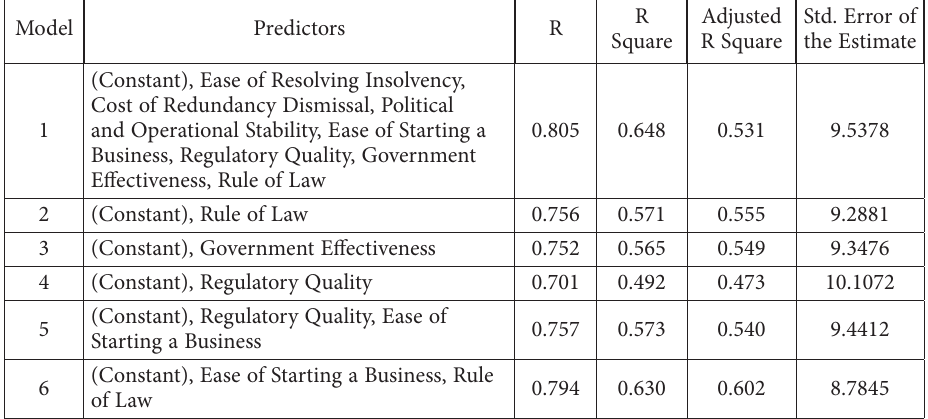
Table 3. Model summary (sub-pillars): regression model between DESI4 and the sub-pillars of Institu- tions – Stepwise algorithm